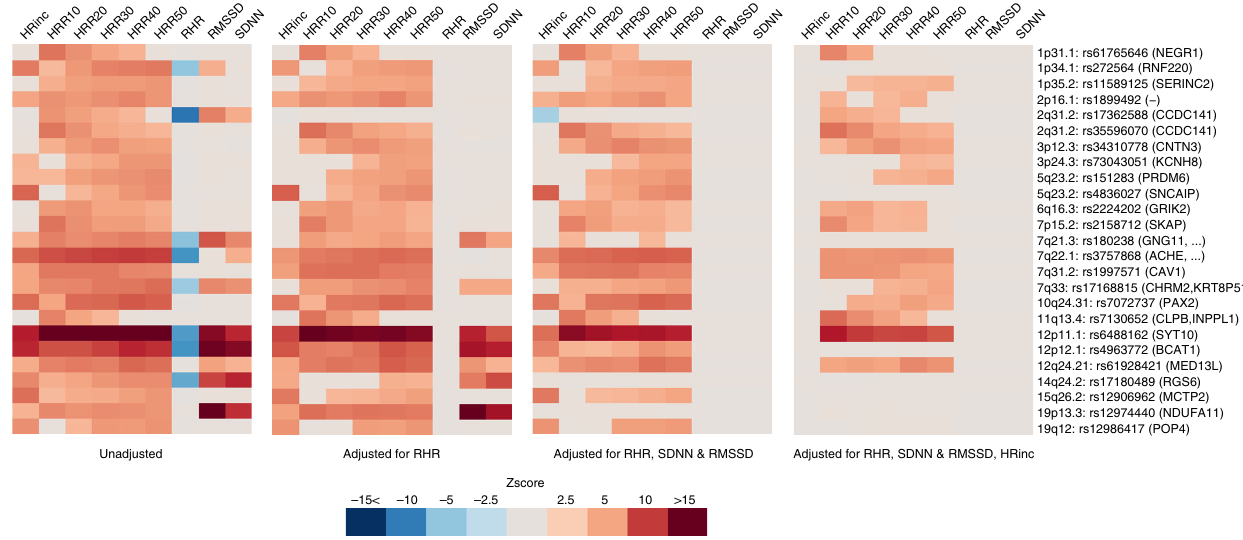
Fig. 3 Pleiotropic effects of the 25 independent genetic signals on heart-rate (HR) phenotypes. Four heat plots depict Z-scores of each SNP association with resting HR (RHR), HR variability (RMSSD and SDNN), HR increase (HRinc), or HR recovery (HRR10- 50) in 1 univariate and 3 multivariable models (as described below each heat plot). Only Bonferonni p < 0.05 signi fi cant associations are shown, Z-scores were aligned to the allele that increases HR recovery. Nearby genes are shown between